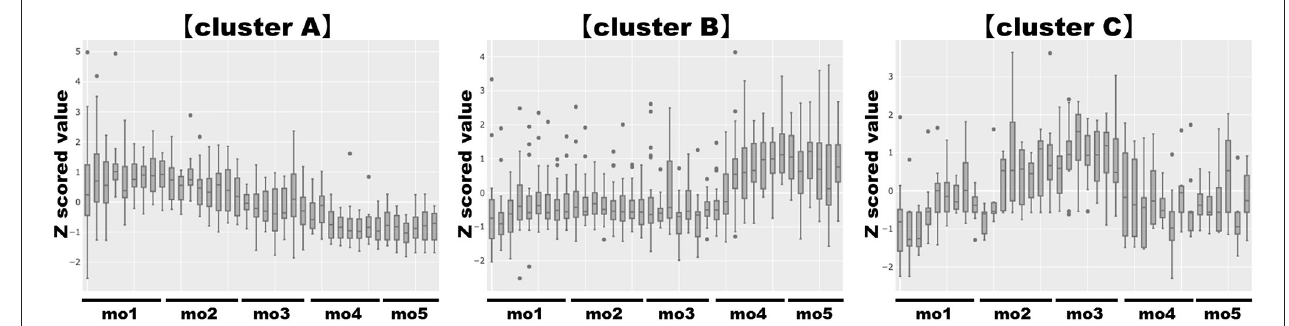
FIGURE 3 | Clustering analysis of bioactive milk components, the microbiome at the species level, and the metabolites in infant feces. Those with similar characteristics (similar fluctuation patterns) were categorized into three clusters, cluster A, cluster B, and cluster C. “Cluster A” showed high values in the early-lactation period and low values in the late-lactation period; “cluster B” showed low values in the early-lactation period and high values in the late-lactation period; “cluster C” did not show a characteristic tendency throughout the lactation period. Categorized factors: (cluster A) 2 ′ -fucosyllactose, 3-fucosyllactose, 3 ′ -sialyllactose, 6 ′ -sialyllactose, formate, hypoxanthine, immunoglobulin A, lactoferrin, lactose, lysozyme, trimethylamine N-oxide, tryptophan, urea, Bifidobacterium breve , Staphylococcus epidermidis , Veillonella ratti . (cluster B) 5-Aminopentanoate, acetate, alanine, aspartate, butyrate, cadaverine, carnitine, choline, creatine, fucose, fumarate, glucose, lactate, o-phosphocholine, propionate, pyruvate, succinate, taurine, threonine, tyrosine, Bifidobacterium longum subsp. infantis , Citrobacter unclassified Citrobacter , Clostridioides mangenotii , Clostridium neonatale , Enterococcus faecium , Escherichia coli , Streptococcus infantis . (cluster C) Glutamate, glycine, isoleucine, leucine,